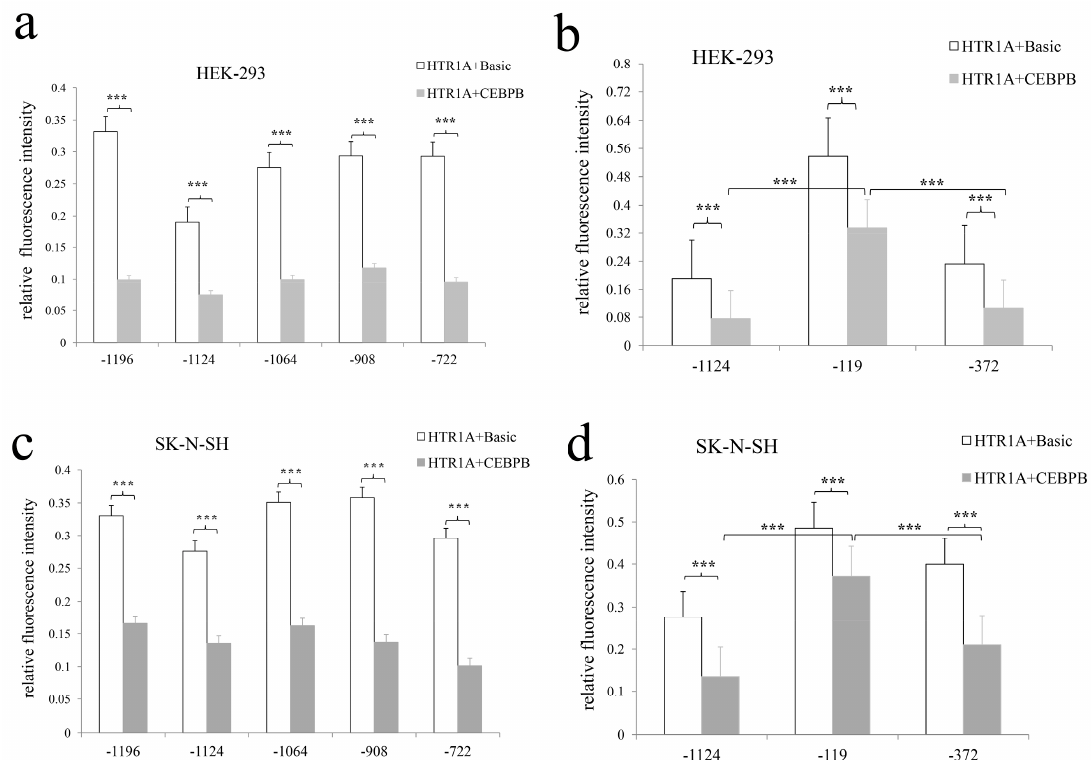
Figure 5. Effect of CEBPB on other fragments through the co-transfection of CEBPB with multiple target fragments in the two cell lines, we found that all sequences with the common region -722 bp - -372 bp strongly responded to CEBPB and were significantly inhibited by CEBPB. However, the inhibition degrees of the sequences were different. * 0.02 < p < 0.05, ** 0.00 < p <= 0.02, *** p<=0.001.